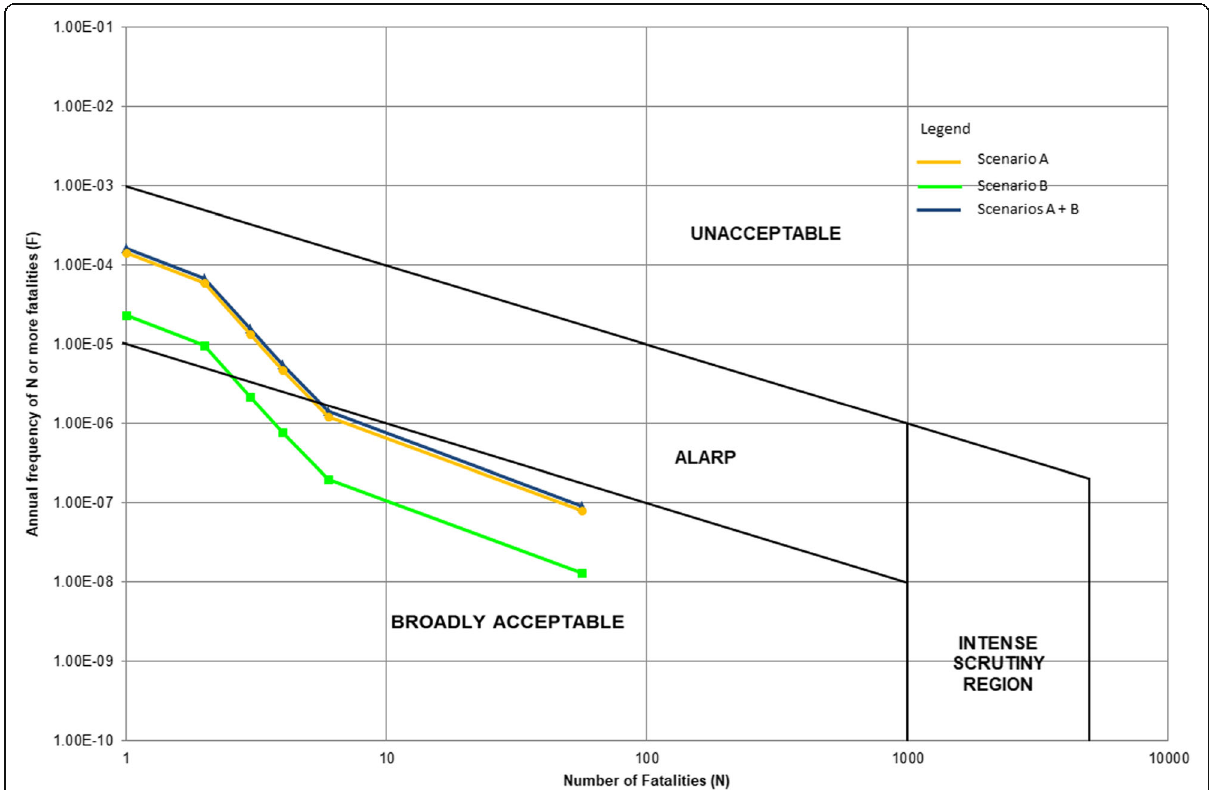
Fig. 13 F - N curves based on the Wong et al. (2004) approach for the